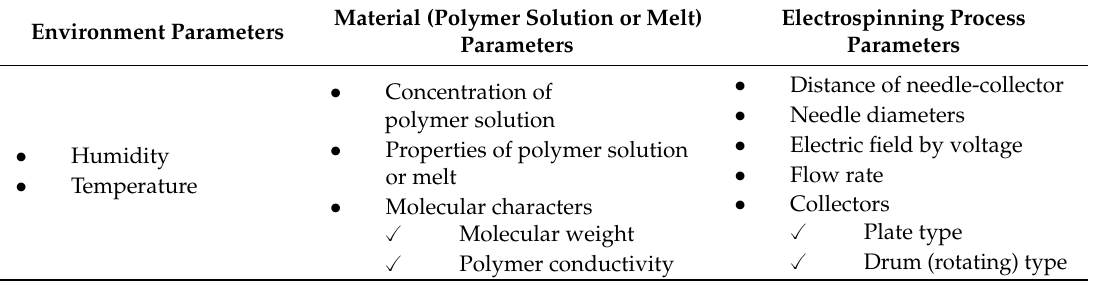
Table 1. Various electrospinning parameters were described. The parameters should be significantly considered because they could a ff ect electrospun fibrous product